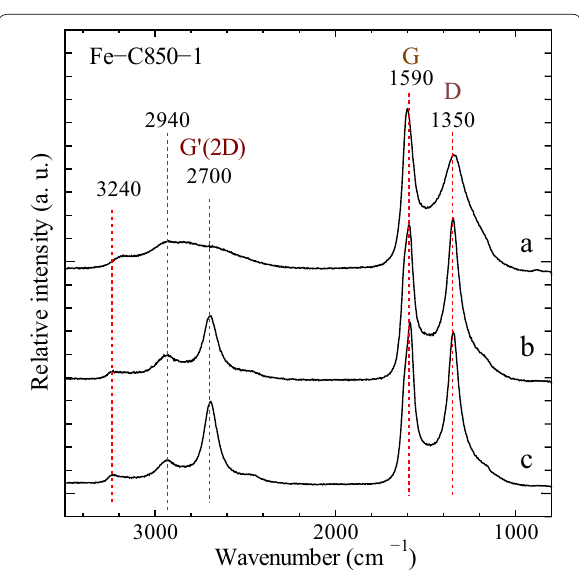
Fig. 2 Measurement-point dependence of Raman spectral line-shape observed on Fe-C850-1 sample: a, Raman spectrum with little or no G’-band; b and c, Raman spectrum with